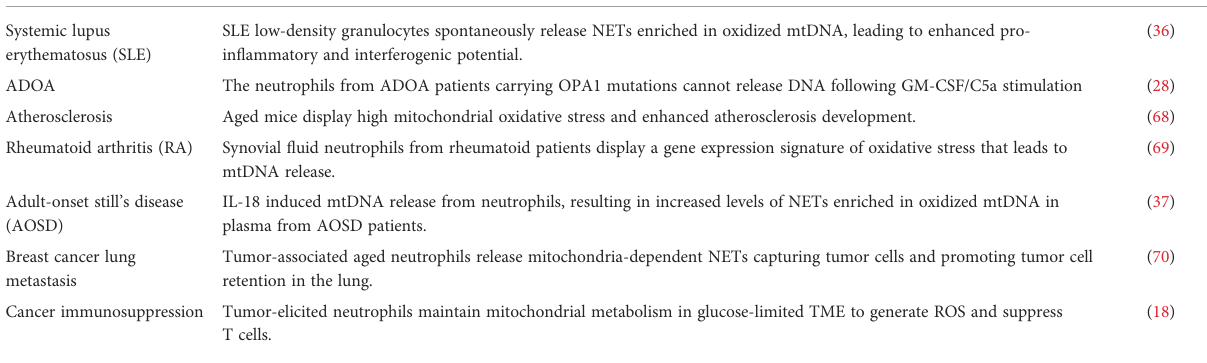
TABLE 2 Neutrophil mitochondria-associated diseases.